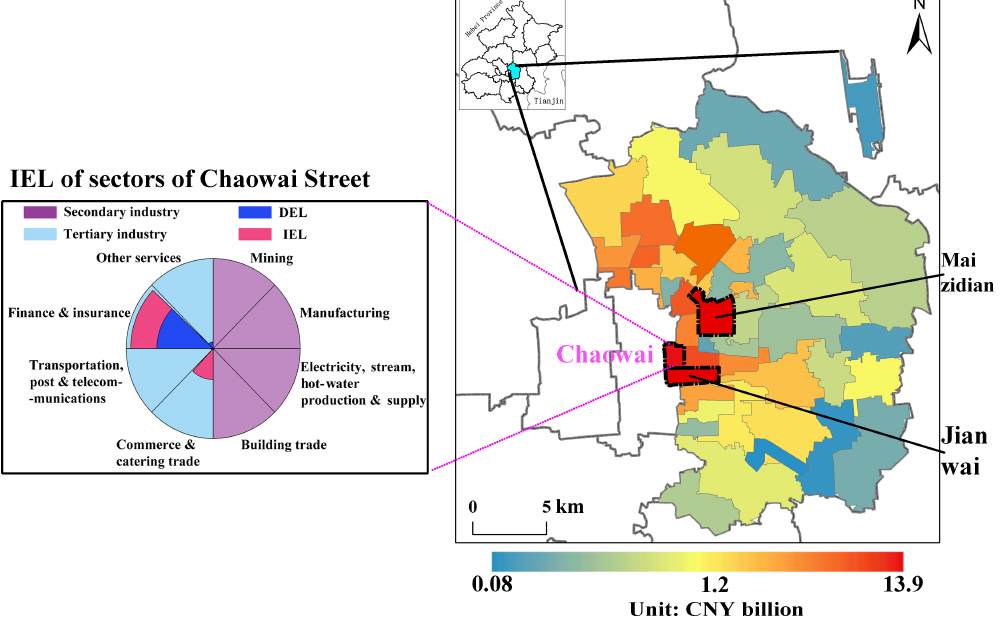
Figure 5. The right panel shows the ripple effects of the indirect economic loss (IEL) of the Chaoyang District; the left panel shows the direct (DEL) and indirect (IEL) economic loss of the sectors of the secondary industry and the tertiary industry of Chaowai